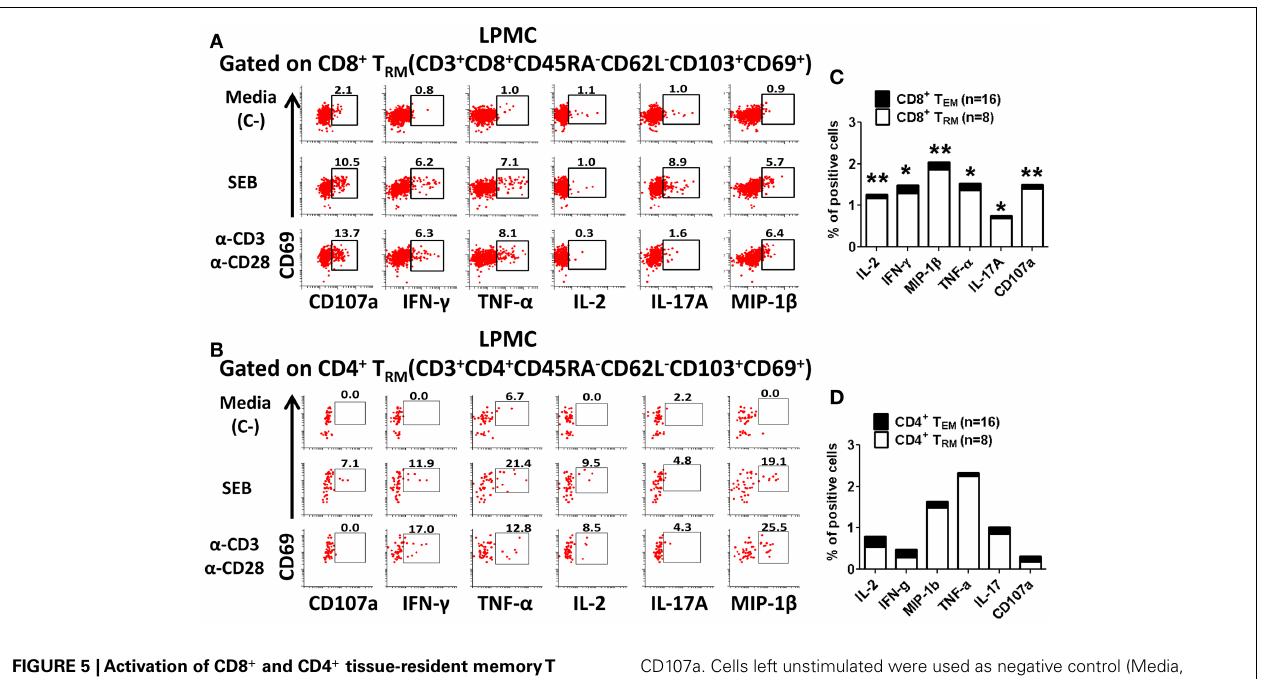
FIGURE 5 |Activation of CD8 + and CD4 + tissue-resident memoryT (T RM ) cells in gastric LPMC . Representative plot of the activation of gastric LPMC CD8 + (A) or CD4 + (B) T RM (CD62L − CD45RA − CD69 + CD103 + ) by two stimulants: (1) staphylococcal enterotoxin B (SEB; 10 µ g/ml) and (2) anti-CD3/CD28 beads ( α -CD3 α -CD28) to produce IL-2, IFN- γ , MIP-1 β ,TNF- α , IL-17A, and up-regulation of the expression of